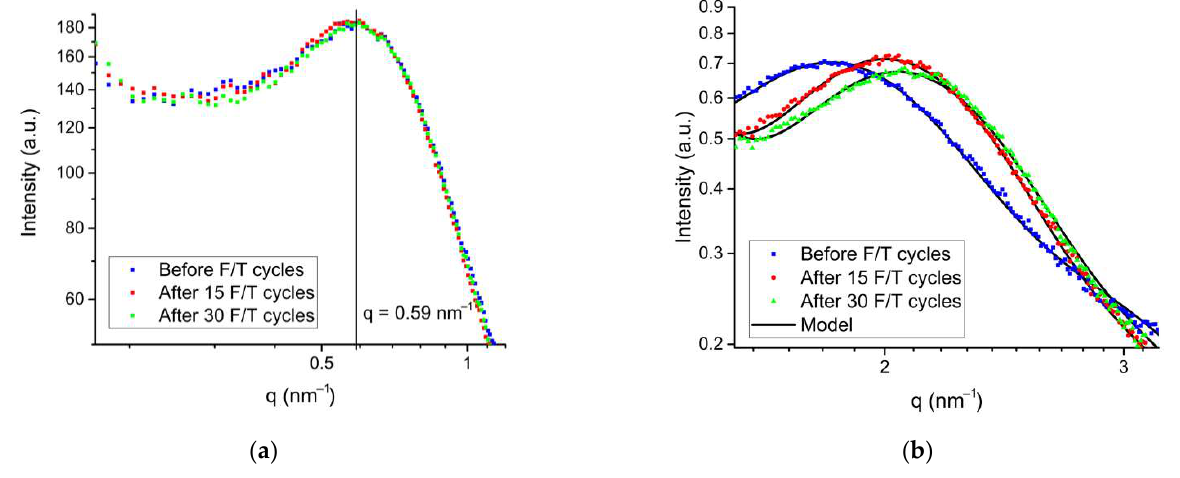
Figure 4. Experimental and model SAXS profiles of the membranes before and after 15 and 30 F/T cycles in the region of the lamellar structure peak ( a ) and ionic domain peak ( b ).